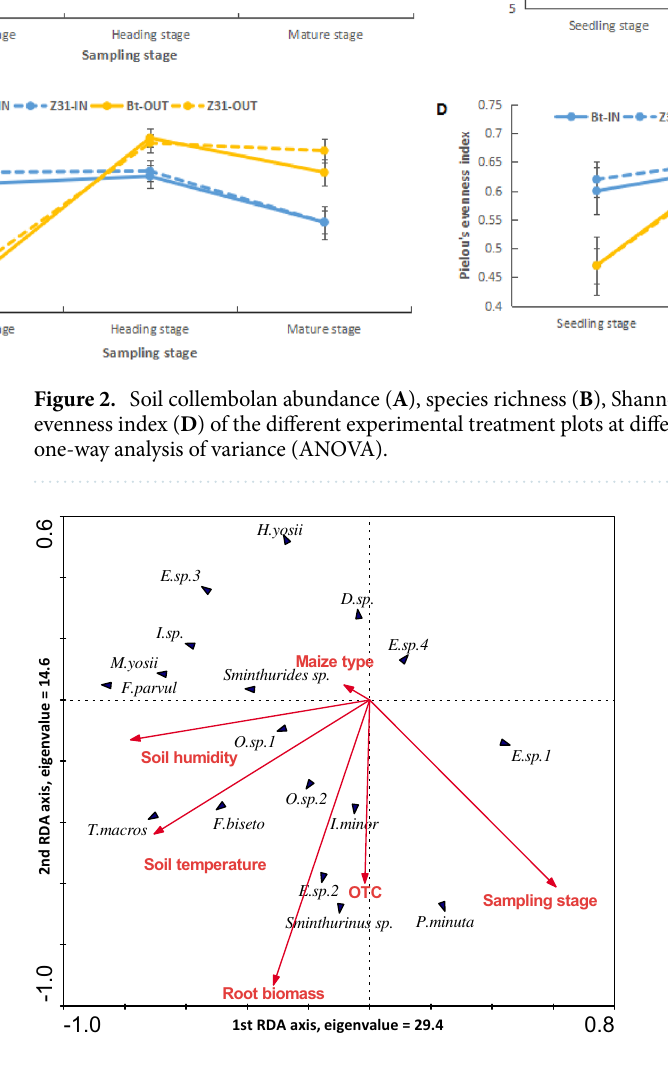
Figure 3. Redundancy analysis (RDA) for indicating associations of collembolan communities with environmental variables.